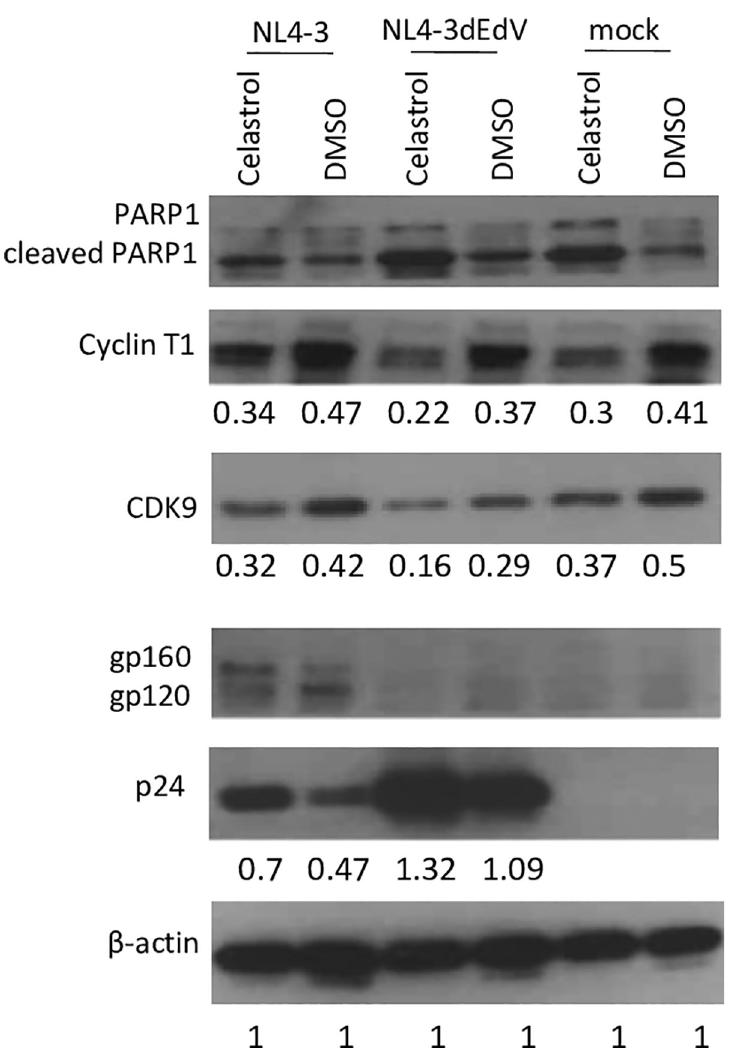
Fig 7. HIV-1 infection of celastrol-treated cells. Jurkat cells were treated with 0.4 μ M celastrol or DMSO at the time of infection with either wild type HIV-1 NL4-3 or NL4-3 Δ Env/Vpr (deleted for env and vpr genes). At 17 hours post- infection, cultures were washed with fresh medium and further incubated with celastrol (0.4 μ M) or DMSO for 24 hours; cell extracts were then prepared and the indicated proteins were analyzed in an immunoblot. The digital protein images were quantified relative to β -actin by Photoshop. A complete biological replicate experiment as that shown was performed with similar